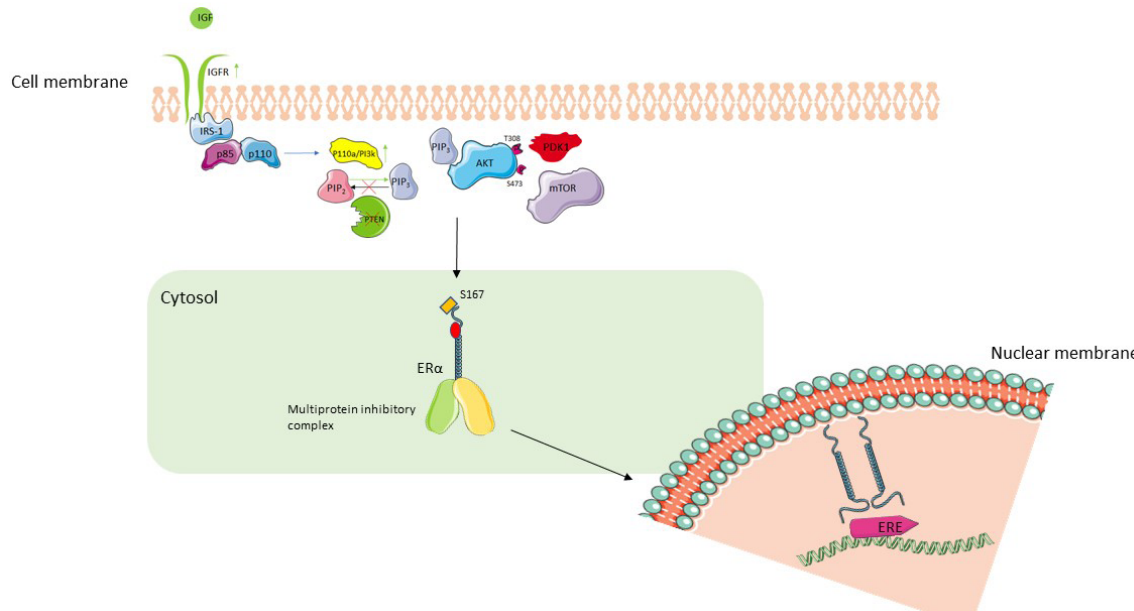
Figure 1. PI3K/Akt/mTOR pathway and interaction with ER signaling. The binding of IGF to IGFR leads to autophosphorylation of the receptor and IRS-1. IRS-1 leads to splitting of heterodimeric complex (p85, p110) and activation of p110 which via its PI3K activity converts PIP to PIP . PIP translocates to the plasma membrane and binds to Akt, allowing phosphorylation at 2 3 3 T308 by PDK1 which achieves partial activation of Akt. Full activation of Akt is achieved by phosphorylation at S473 by mTOR. Active Akt phosphorylates S167 facilitate activation of downstream ER nuclear transcriptional activity [39]. Upregulation of IGFR, constitutively active PI3K or loss of PTEN leads to activation of PI3K/Akt/mTOR pathway, increased ligand-independent activation of ER, and resistance to ET. IGF: insulin growth factor; IGFR: IGF receptor; IRS-1: IR substrate-1; ERE: estrogen response element ; PTEN: phosphatase and tensin homolog; PDK1: 3-phosphoinositide-dependent protein kinase-1; ER: estrogen